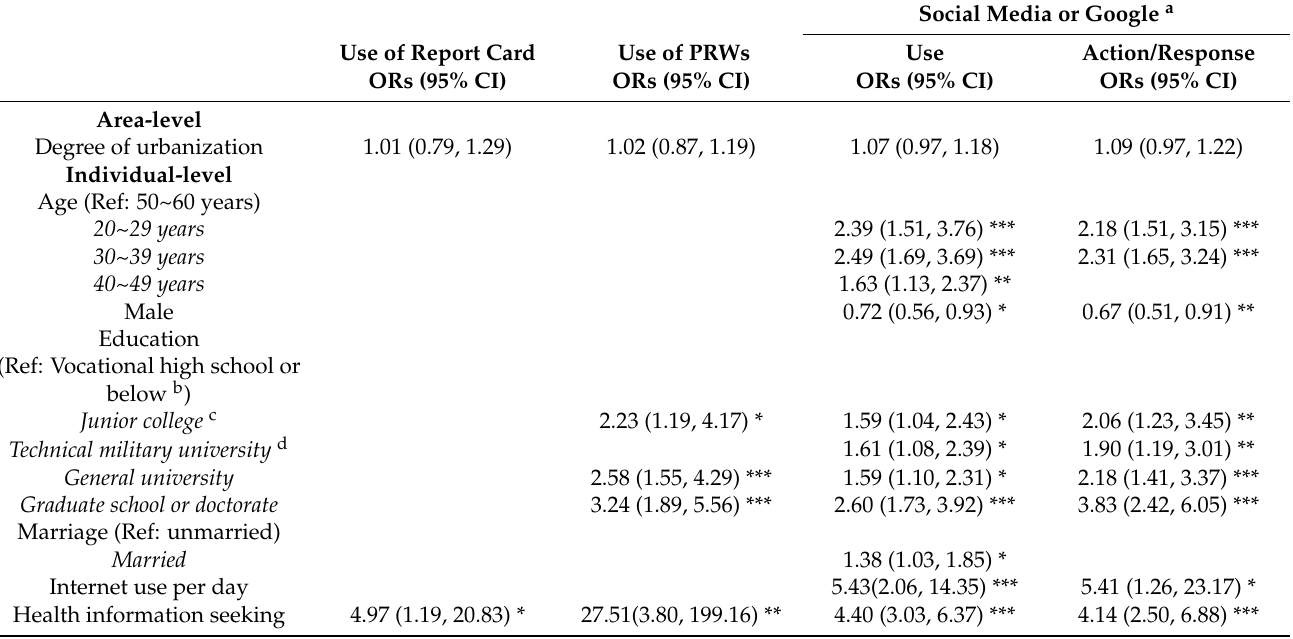
Table 3. Factors related to the use of official report cards, private PRWs, social media or Google and factors related to action based on social media or Google ( n =